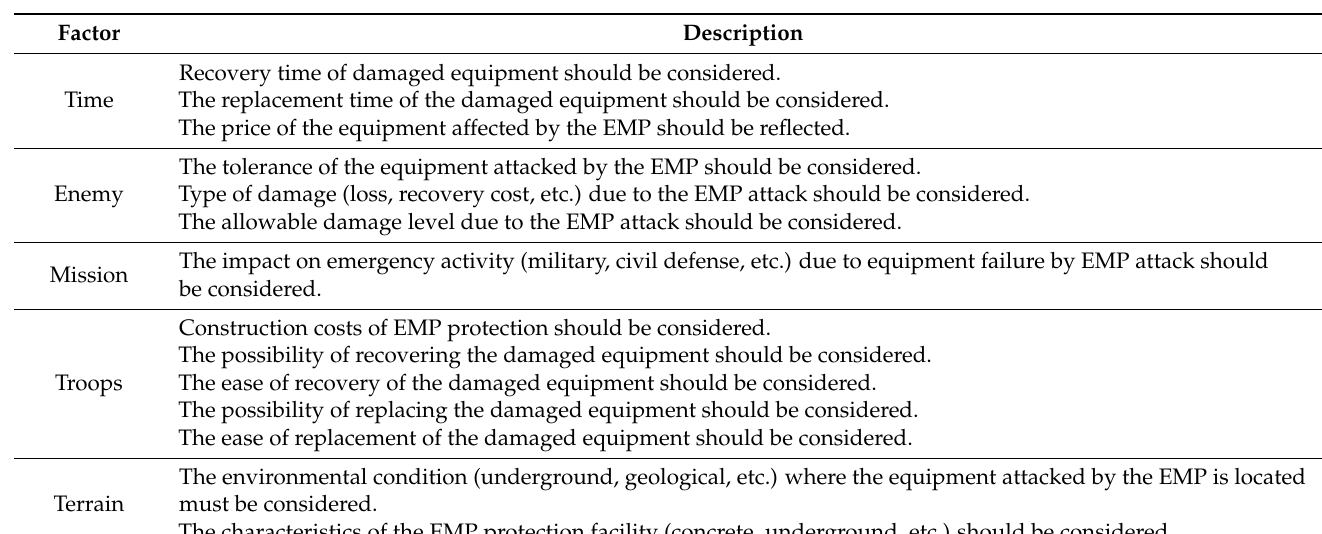
Table 1. Decision-making factors to determine EMP protection level.